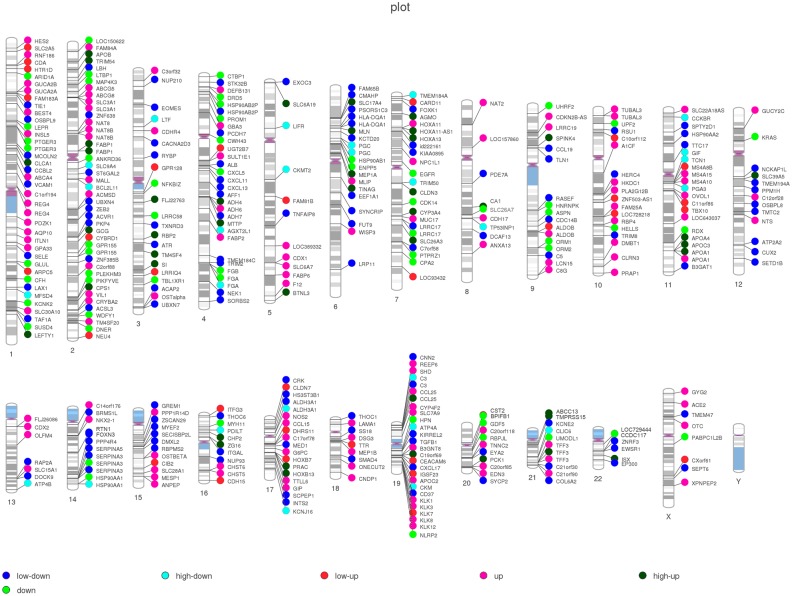
Whole chromosome view of expression levels of the 400 top DEGs mapped to 23 chromosomes.Each circle represented one DEG. Expression levels were normalized to six grades (Low-up /4-6 fold, up/7-10 fold, high up/more than 10 fold; Low-down /4-6 fold, down/7-10fold, high down/more than 10 fold).